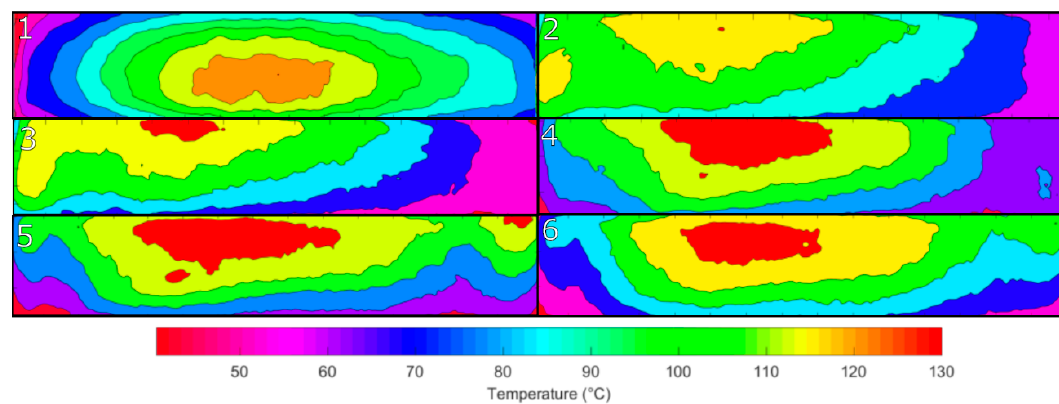
Figure 13. Contour plots of the surface temperature profile after each cycle of processing. Number denotes the process iteration. The scale within each image and across all the images applies to all of the plots.